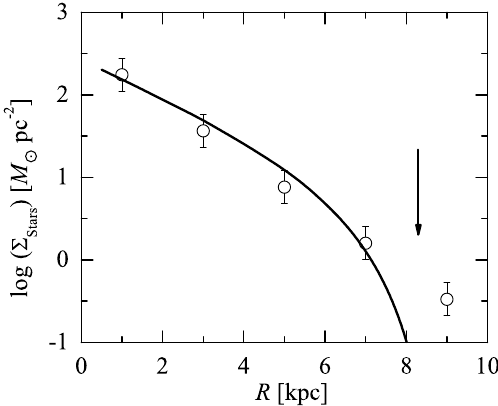
Fig. 3. The surface density profiles of stars in the disk. The solid line denotes the average of 30 models; the circles represent observational data from Corbelli (2003). The arrow indicates the location of a sharp break in the stellar density profile (Ferguson et al.